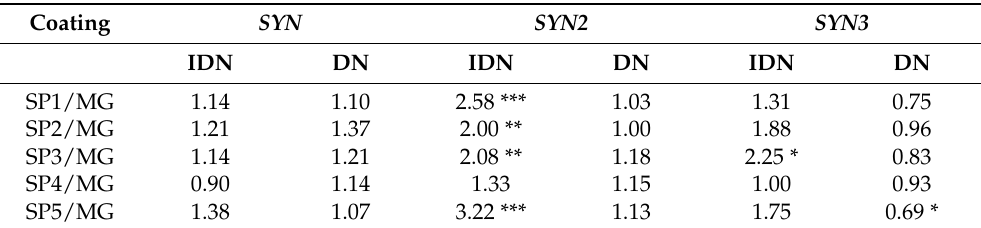
Table 4. The ratio of the expression levels of the synapsin genes in human IDN and DN cultivated on CC compared to those cultivated on MG.